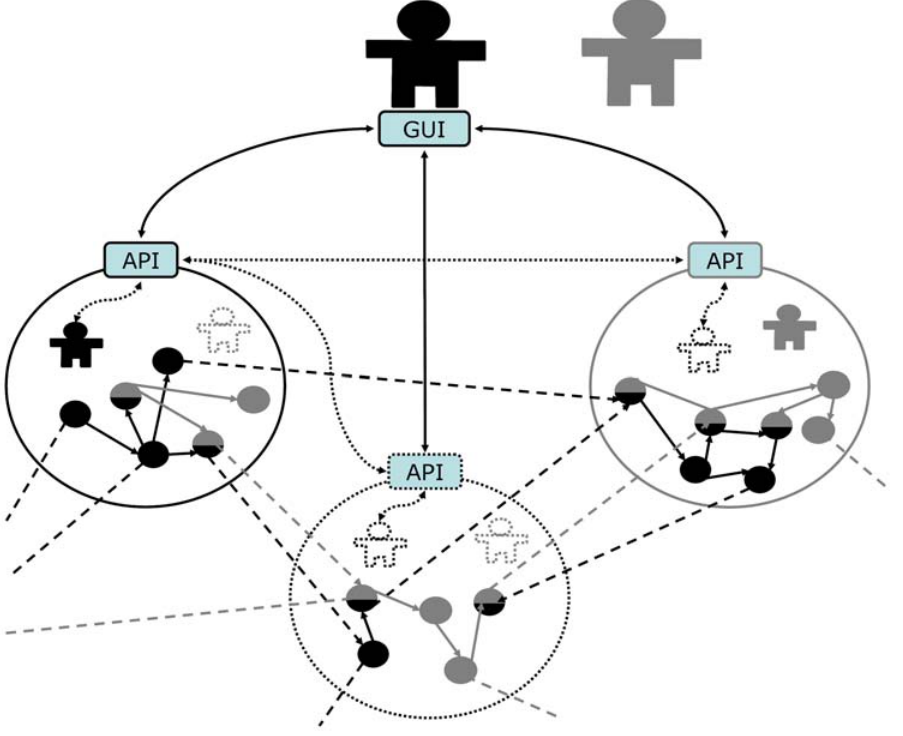
Figure 3. Illustration of the desirable functionality: distinct users, with identities (solid icon) managed in distinct S3DB deployments (circular compartments), which they control separately, share a distributed and overlapping data structure (arrows between symbols) that they also manage independently: some data elements are shared (mixed color symbols) others are not. This will require the identity verification to propagate between deployments peer-to-peer (P2P, dotted lines), including to deployments where neither user maintains an identity (dotted circular compartment). This is in contrast with the conventional approach of having distinct users manage insular deployments with permissions managed at the access point level.